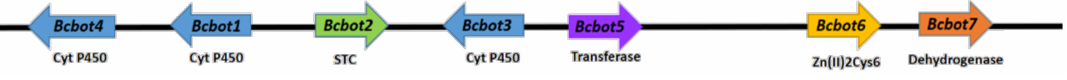
Figure 2. The botrydial gene cluster in the B. cinerea strain